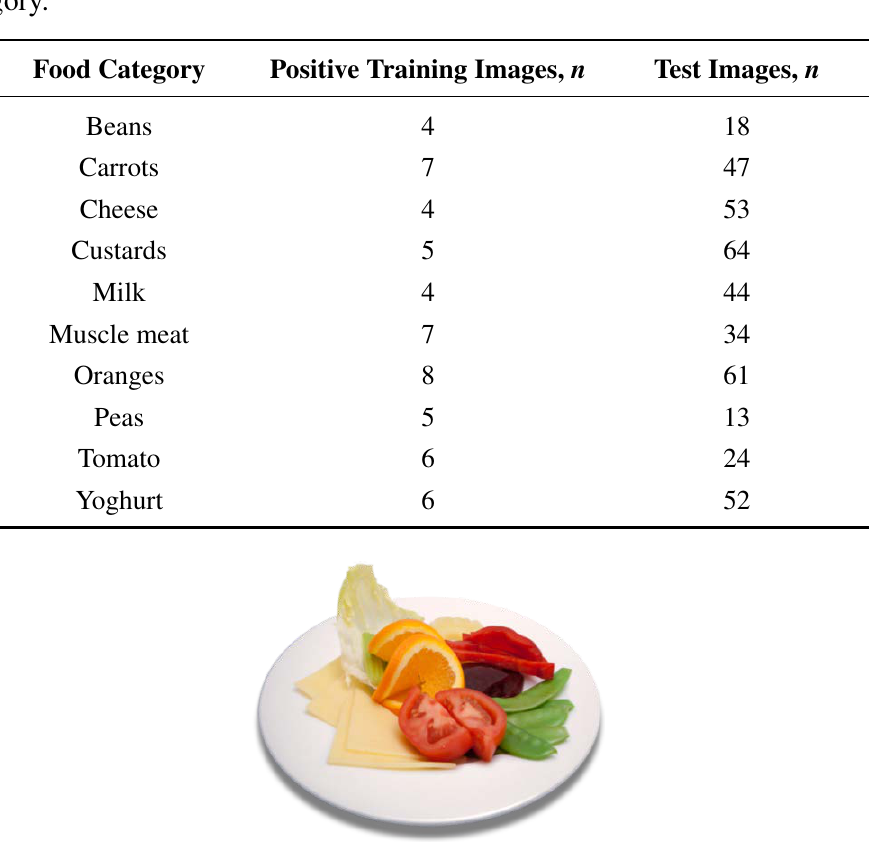
Figure 2. An example of a food image containing five food categories: cheese, tomato, oranges, beans, and carrots.